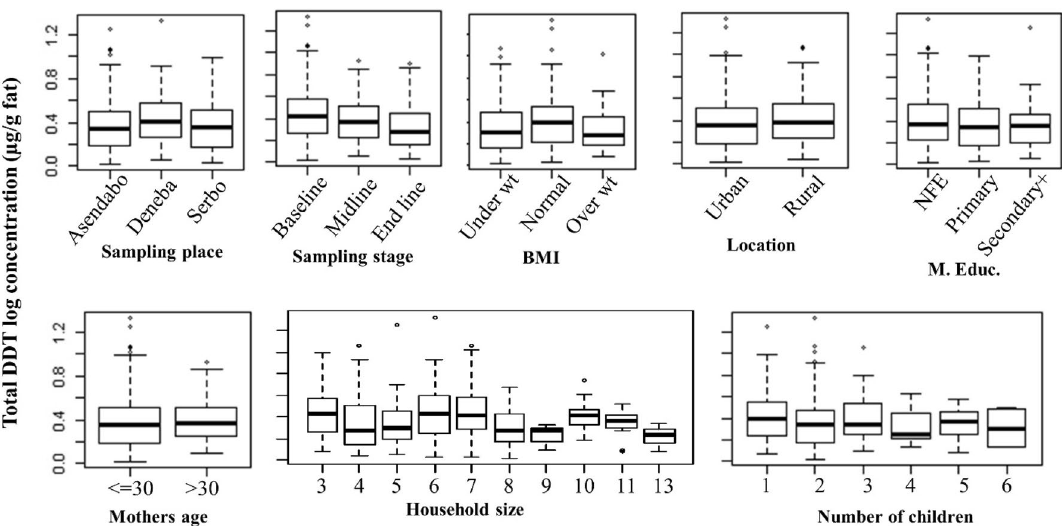
Figure 2. Box and whisker plot of total DDT concentration (µg/g milk fat) in relation to different categorical variables. NFE = No formal education, BMI = Body mass index, M. Educ. = educational status of mothers.